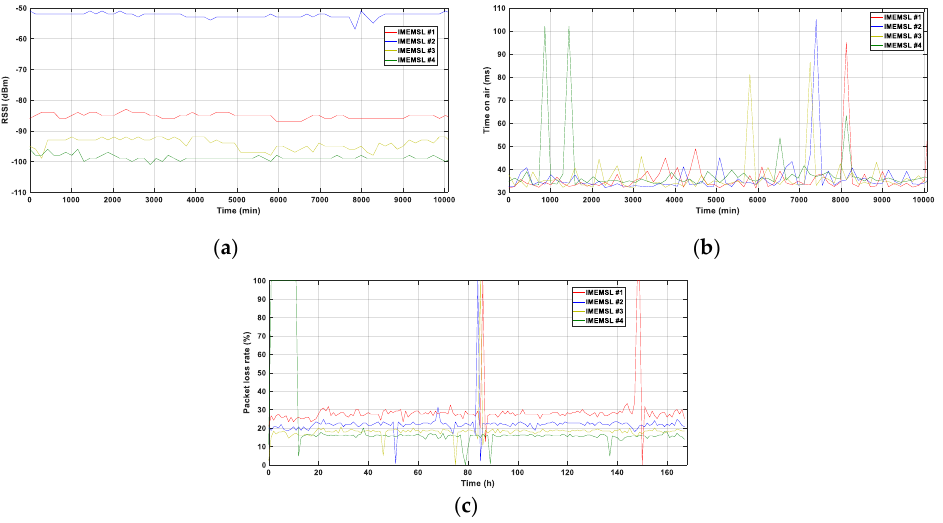
Figure 10. LoRa characteristics: ( a ) RSSI; ( b ) Time on Air;( c ) Packet loss rate.